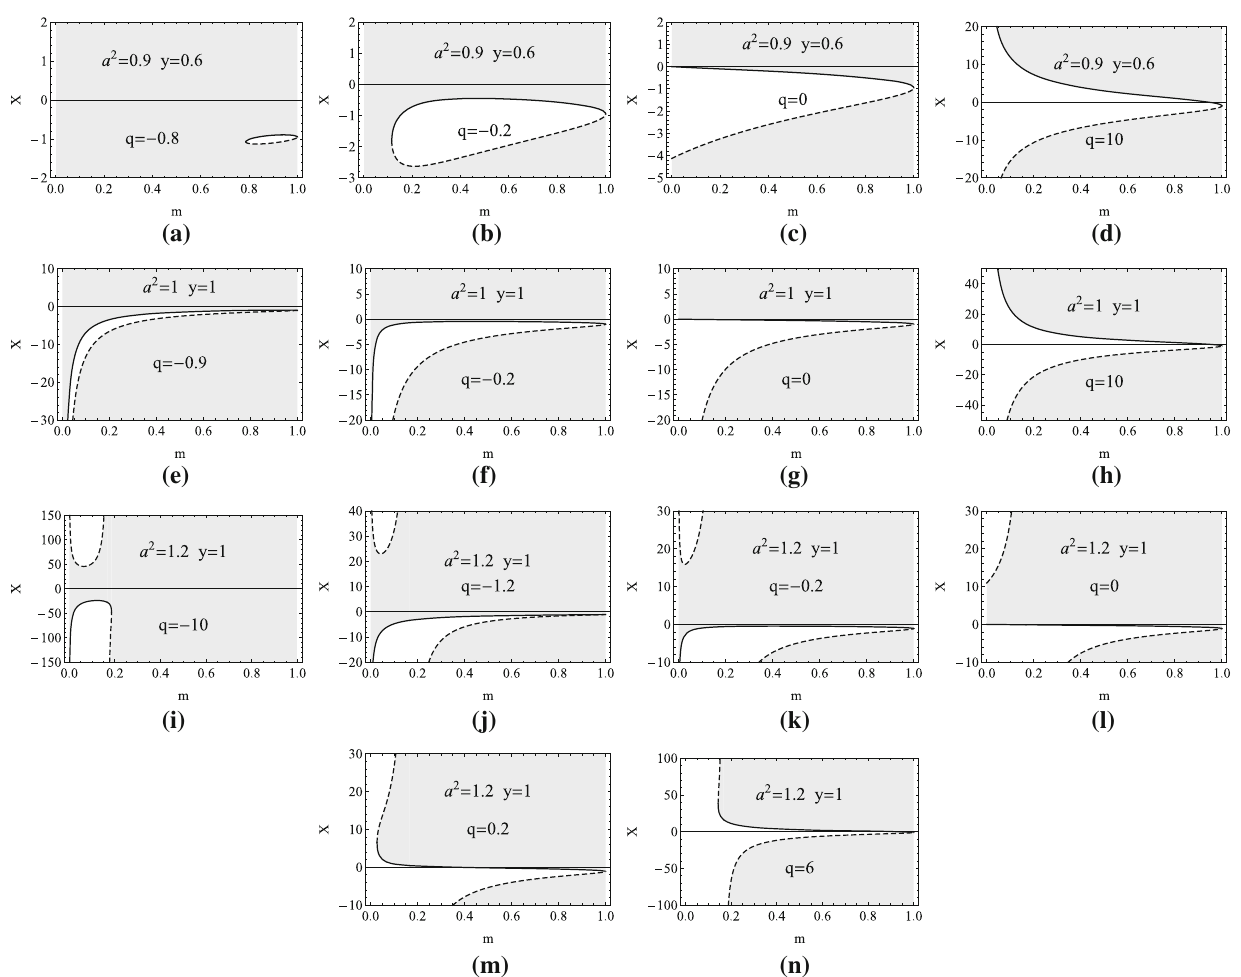
Fig. 2 Graphs of potentials X θ + ( m ; q , y , a ) (full curve) and X θ − ( m ; q , y , a ) (dashed curve) depicted for given typical values a 2 , y corresponding successively to cases y < 1 / a 2 (top row), y = 1 / a 2